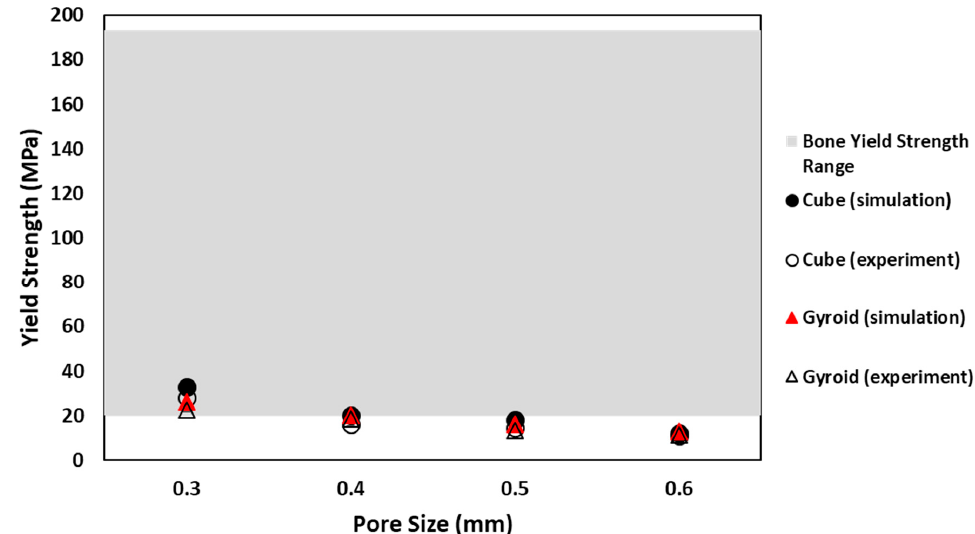
Figure 12. Comparison between numerical and experimental yield strength for cube and gyroid sample in the range of bone yield strength.